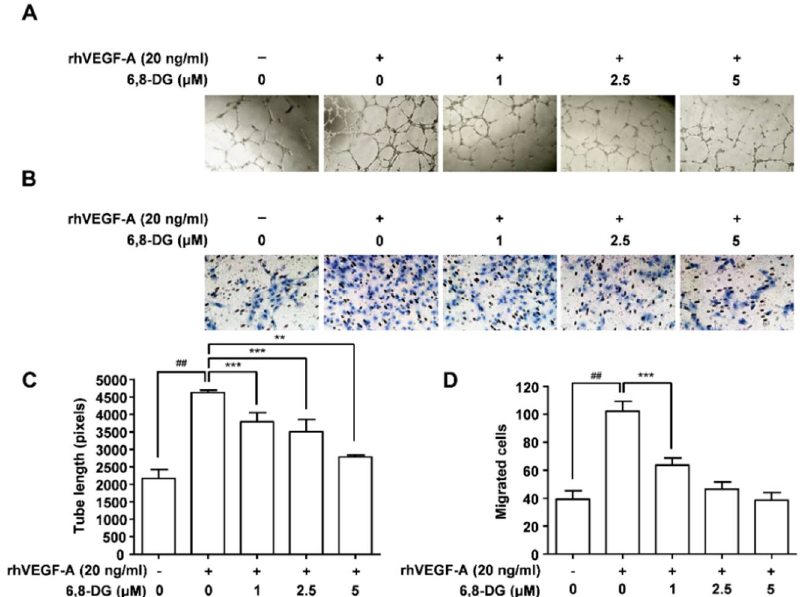
Figure 2. Effects of 6,8-DG on VEGF-A-induced HLMEC tube formation and migration. ( A , C ) Tube formation in HLMECs stimulated rhVEGF-A. Cells were imaged under an inverted phase contrast microscope using a digital single-lens reflex camera. Total tube lengths of a unit area were calculated using the Image J program. ( B , D ) The migrated cells to the underside of membranes were fixed with methanol, stained with hematoxylin solution, and then imaged under an inverted phase contrast microscope using a digital camera. Five digital images per well for ( B ) were obtained, and the numbers of migrated HLMECs were counted. Each sample was assayed in duplicate. Numbers of migrated HLMECs present in 320 mm 2 are presented as a bar diagram. Data are presented as a mean ± S.D. of three independent experiments ( ## p < 0.001, ** p < 0.01, *** p < 0.001).